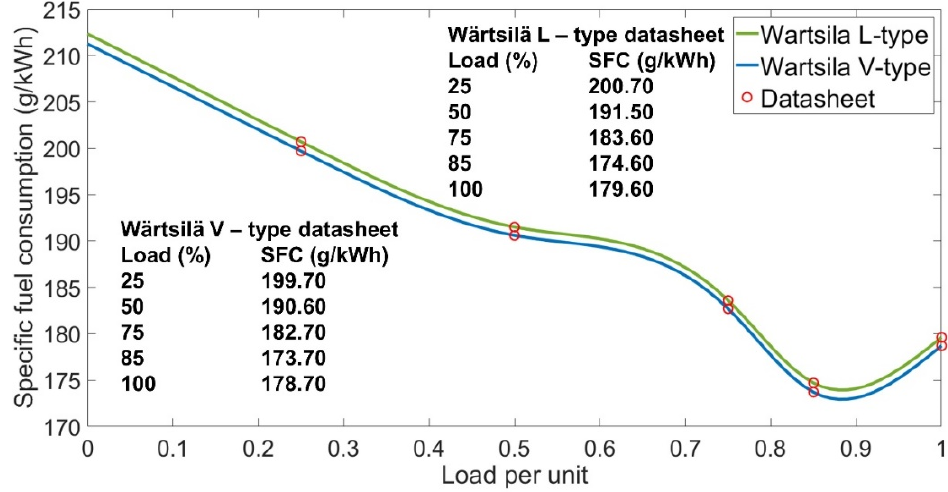
Figure 3. SFC map of Wärtsilä 46F V- and L-type engines at various loads.